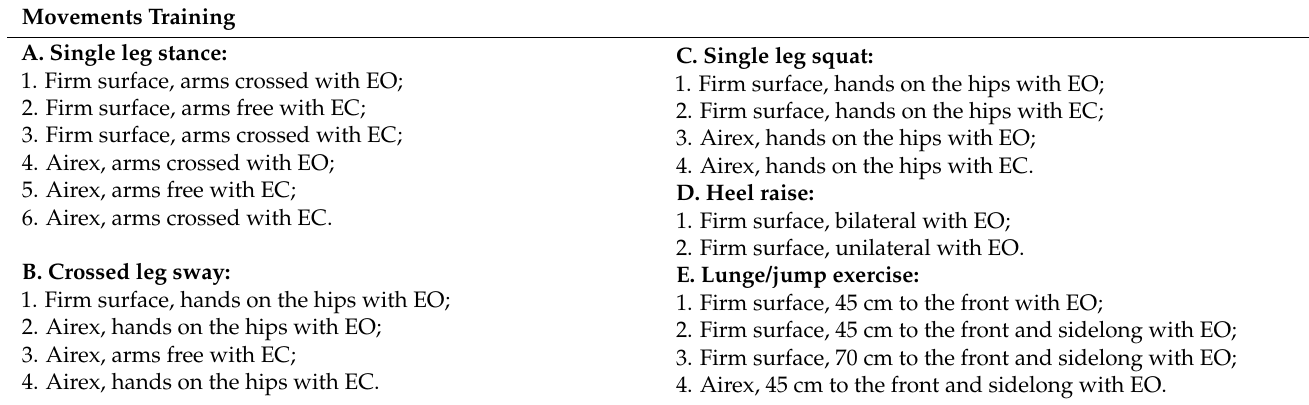
Table 3. Home-based balance training